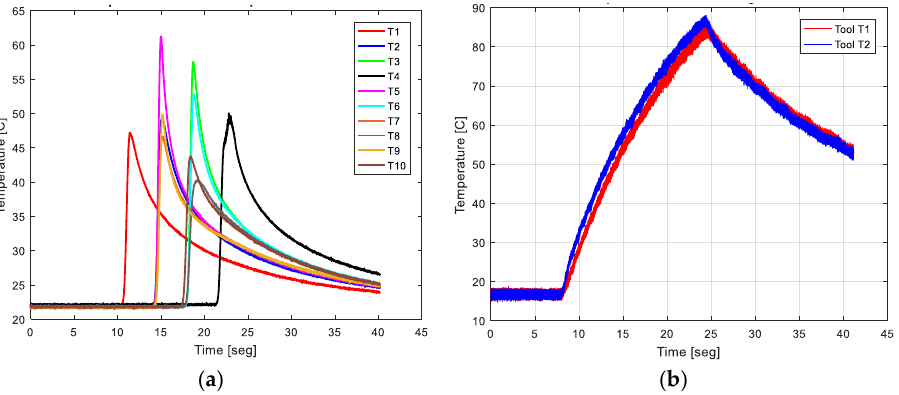
Figure 4. Examples of temperature profiles: ( a ) [0] 8 /Ti6Al4V within stack thermocouples tempera- ture; ( b ) cutting tool lip temperatures.